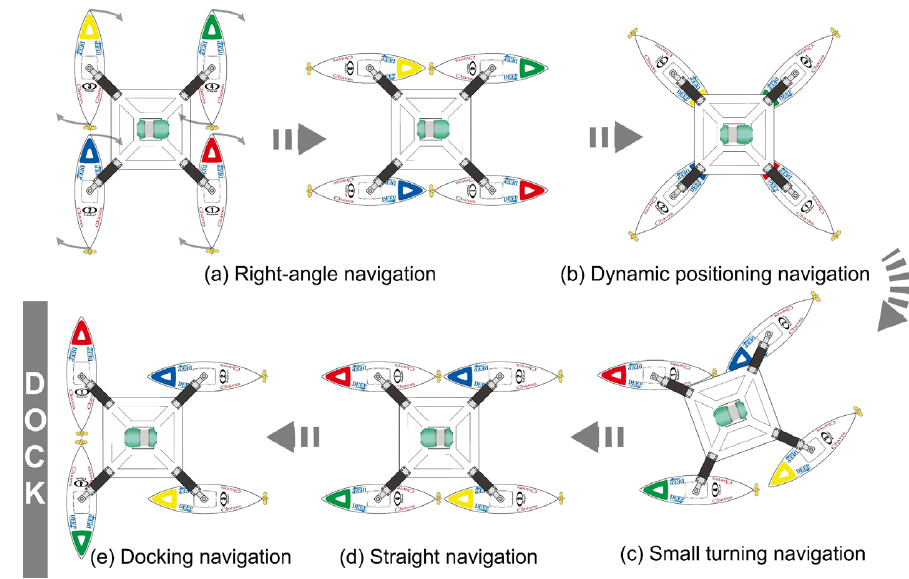
Figure 2. Quadmaran vessel—Modes of operations.